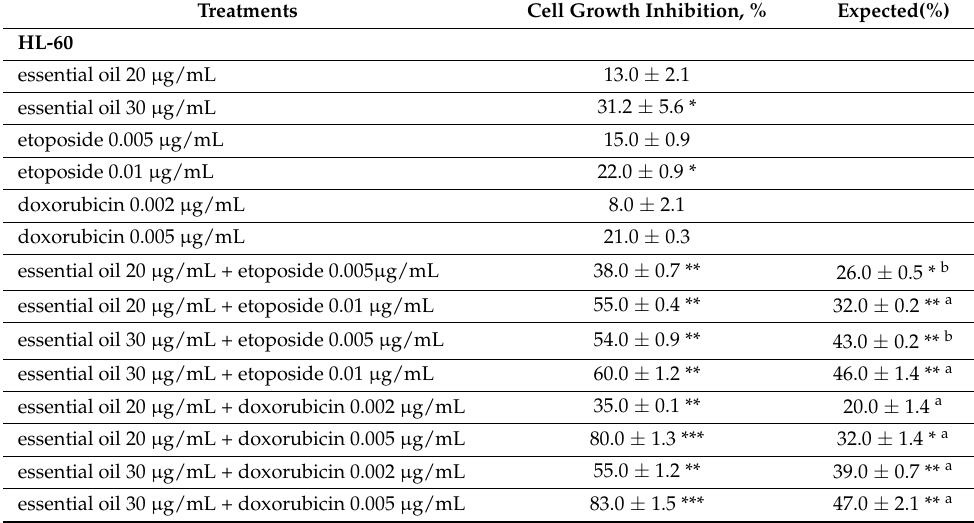
Table 4. Cytotoxic effects of essential oil in combination with etoposide and doxorubicin in HL-60 and HL-60R